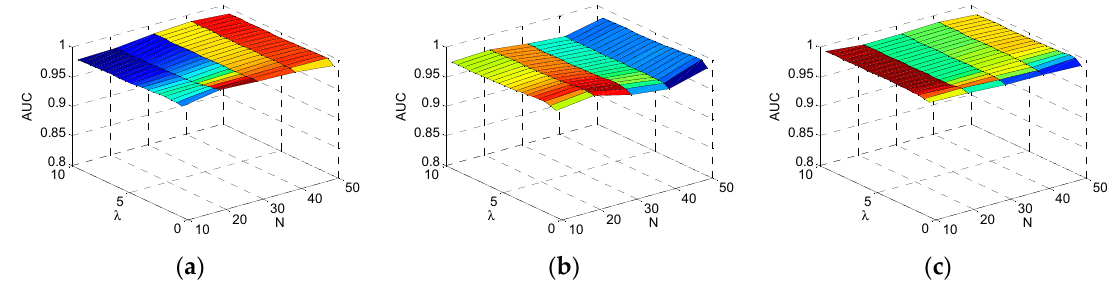
Figure 5. The AUC surfaces of the detection results of LRRaLD with different parameters ( λ and N ) under simple background: ( a ) F1; ( b ) F2; and ( c ) V1.